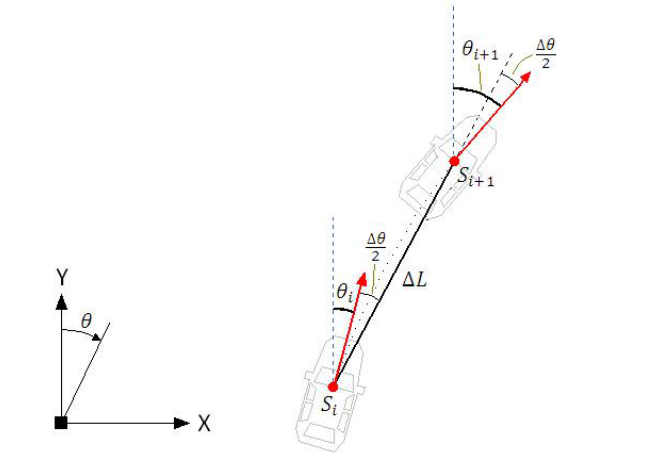
Figure 16. Vehicle’s state reference